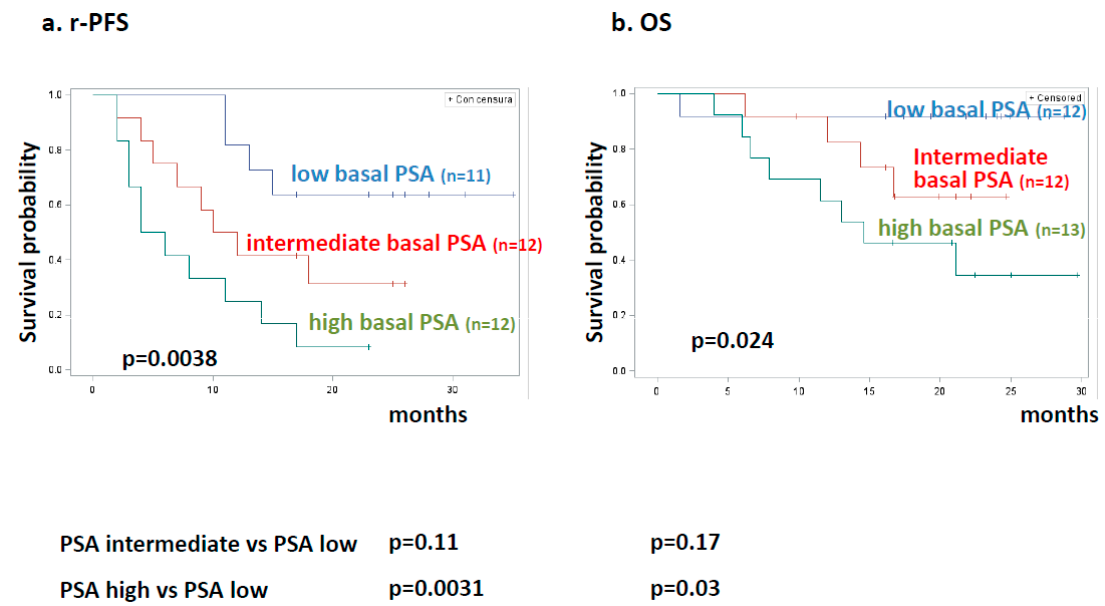
Figure 5. Kaplan–Meier estimates for clinical outcome in patients stratified by basal PSA levels. ( a ) Radiologic progression-free survival (rPFS) in patients stratified for basal PSA levels by tertiles. Blue, red, and green lines represent 11 patients with low, 12 intermediate, and 12 high basal PSA levels, respectively. ( b ) Overall survival (OS) in patients stratified for basal PSA levels by tertiles. Blue, red, and green lines represent 12 patients with low, 12 intermediate, and 13 high basal PSA levels, respectively.